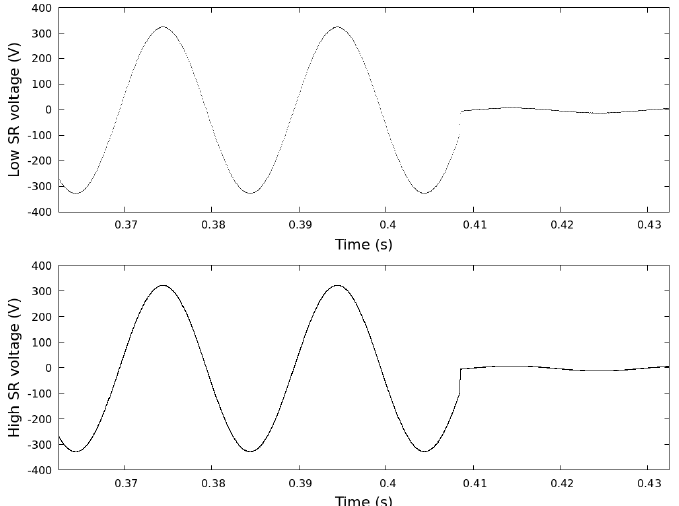
Figure 7. Triggered event for voltage interruption (low and high sampling rate